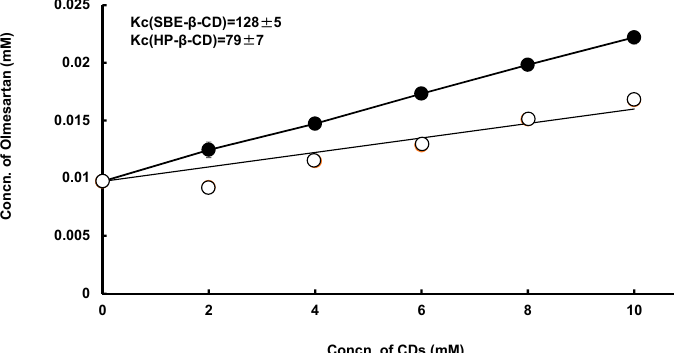
Figure 3. Phase solubility diagrams of olmesartan tablets (OLM)-sulfobutyl ether- β -cyclodextrin (SBE- β -CD), OLM/ SBE- β -CD (close circle) and OLM/HP- β -CD (open circle) systems in water at 25 °C.